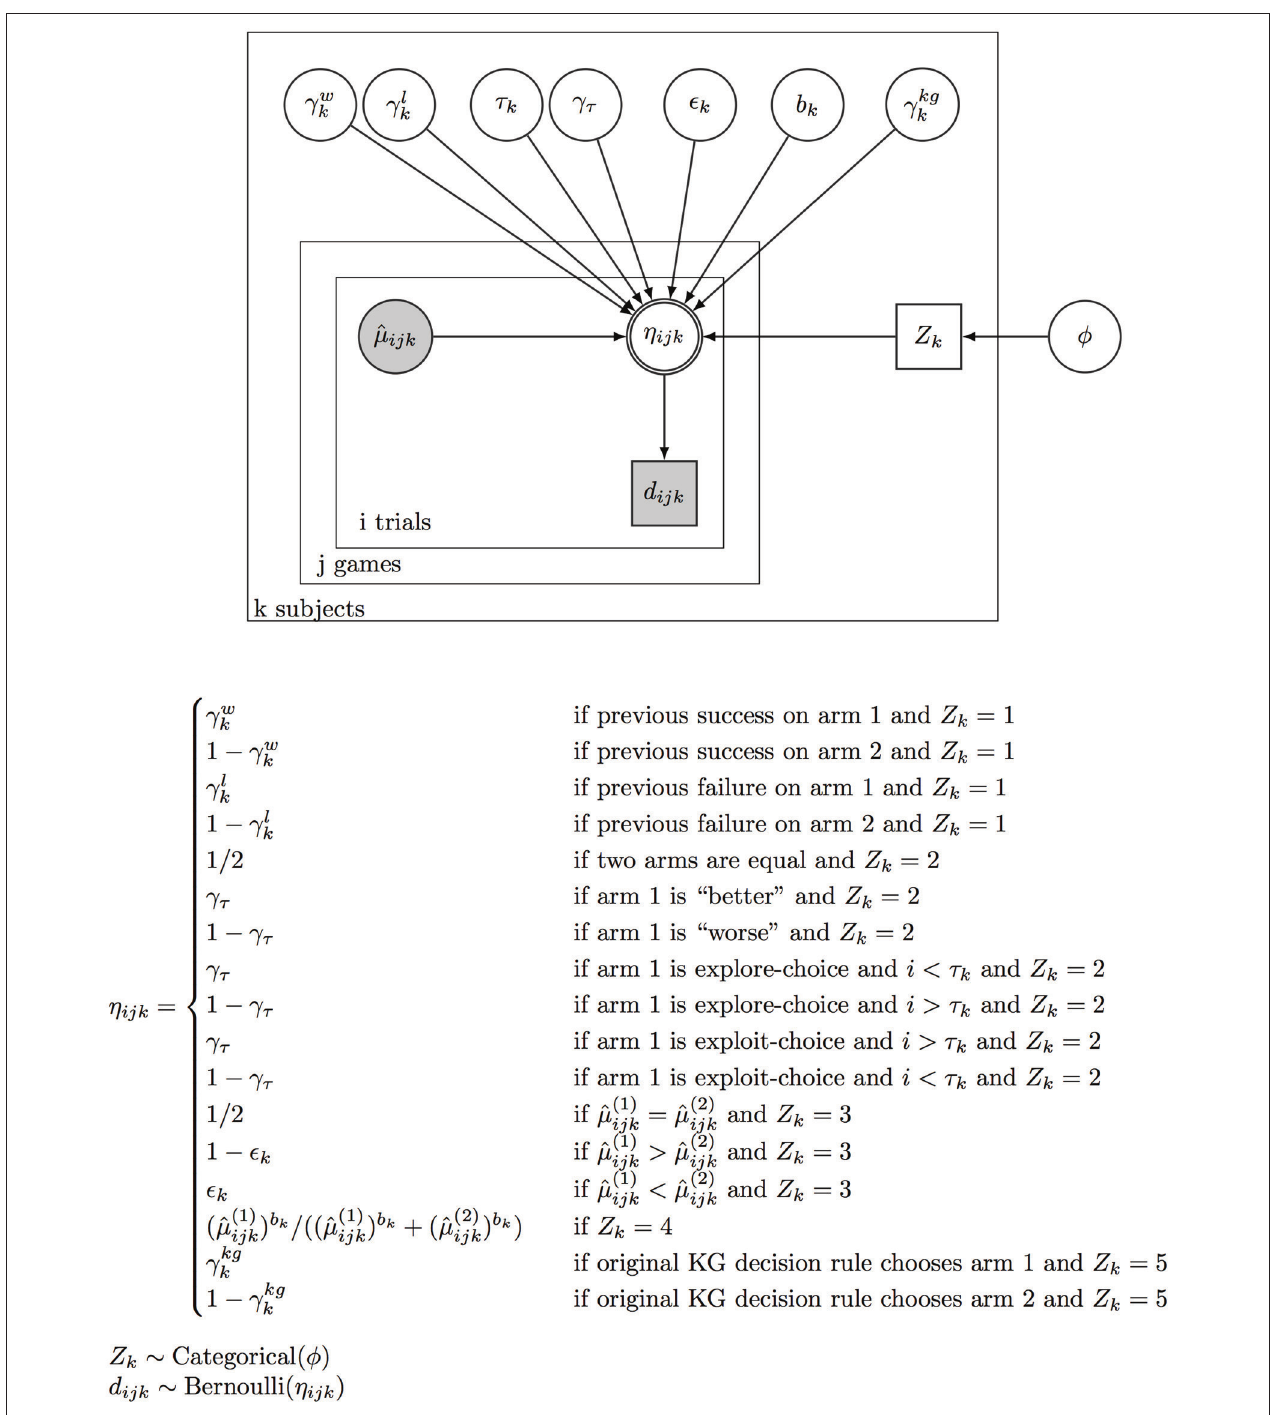
FIGURE 2 | Bayesian model comparison. We simultaneously infer the latent model usage and model parameters for all five different strategic decision-making models, including two learning-independent heuristic models (WSLS, τ -Switch), two learning-dependent heuristic models ( ε -Greedy, Softmax), and Knowledge Gradient, based on observed data (subjects’ actual choices and outcomes). See Materials and Method for more details. In the Bayesian graphical model, a node is double-bordered if it is deterministic (on its parents), otherwise stochastic; a node is gray if it is known/observed, otherwise unknown and to be inferred. Circle node is continuous, whereas rectangular node is discrete. η is the probability for choosing arm 1 for subject k, at trial i of game j. This choice probability is deterministically dependent on the estimated reward rates and the decision policy.